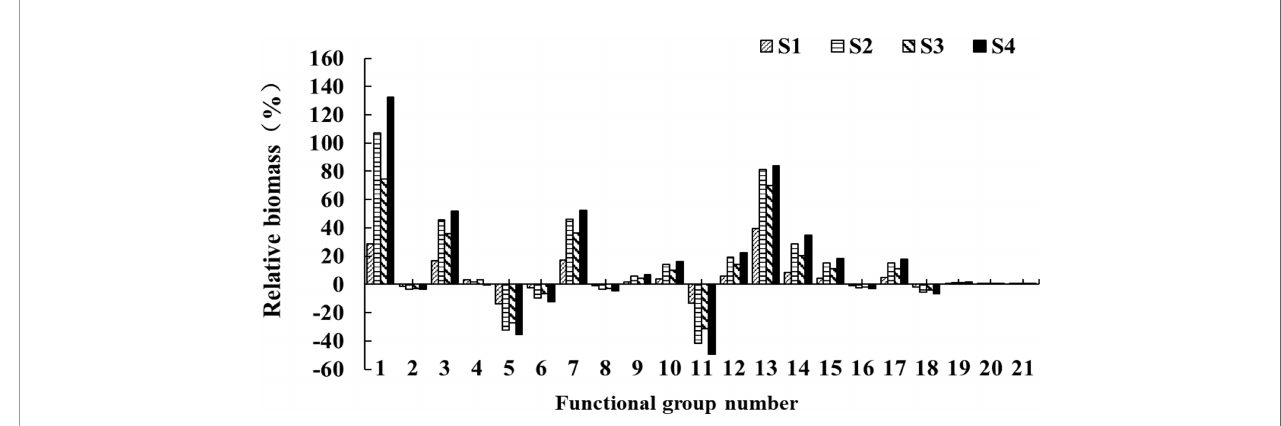
FIGURE 4 | Changes in relative biomass of each functional group after 50 years under four simulated scenarios.